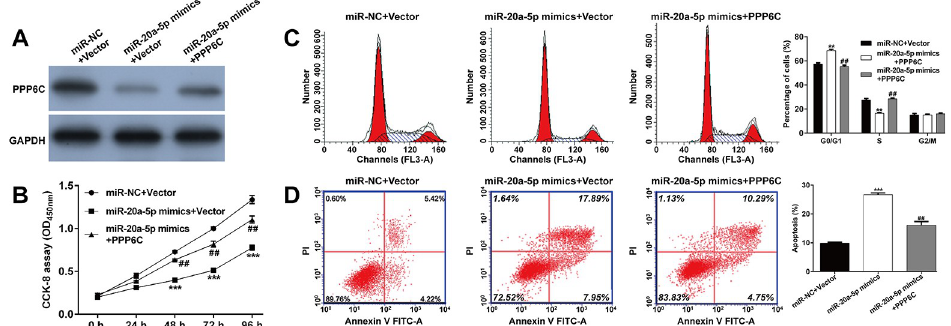
Fig 5. PPP6C overexpression reversed the effects of miR-20a-5p on AML cell proliferation, G1/S transition and apoptosis. THP-1 cells were co-transfected with miR-20a-5p mimics and PPP6C or vector. (A) The expression of PPP6C protein was detected in transfected THP-1 cells. (B) CCK-8 assay was performed to assess the proliferation of transfected THP-1 cells. (C) Flow cytometry with PI staining was applied to analyze cell cycle distribution in transfected THP-1 cells. (D) Apoptotic rate was determined in transfected THP-1 cells. Data are presented as mean ± SD of three independent experiments. �� p < 0.01, ��� p < 0.001, compared with miR-NC +Vector; ## p < 0.01, compared with miR-20a-5p mimics +Vector.